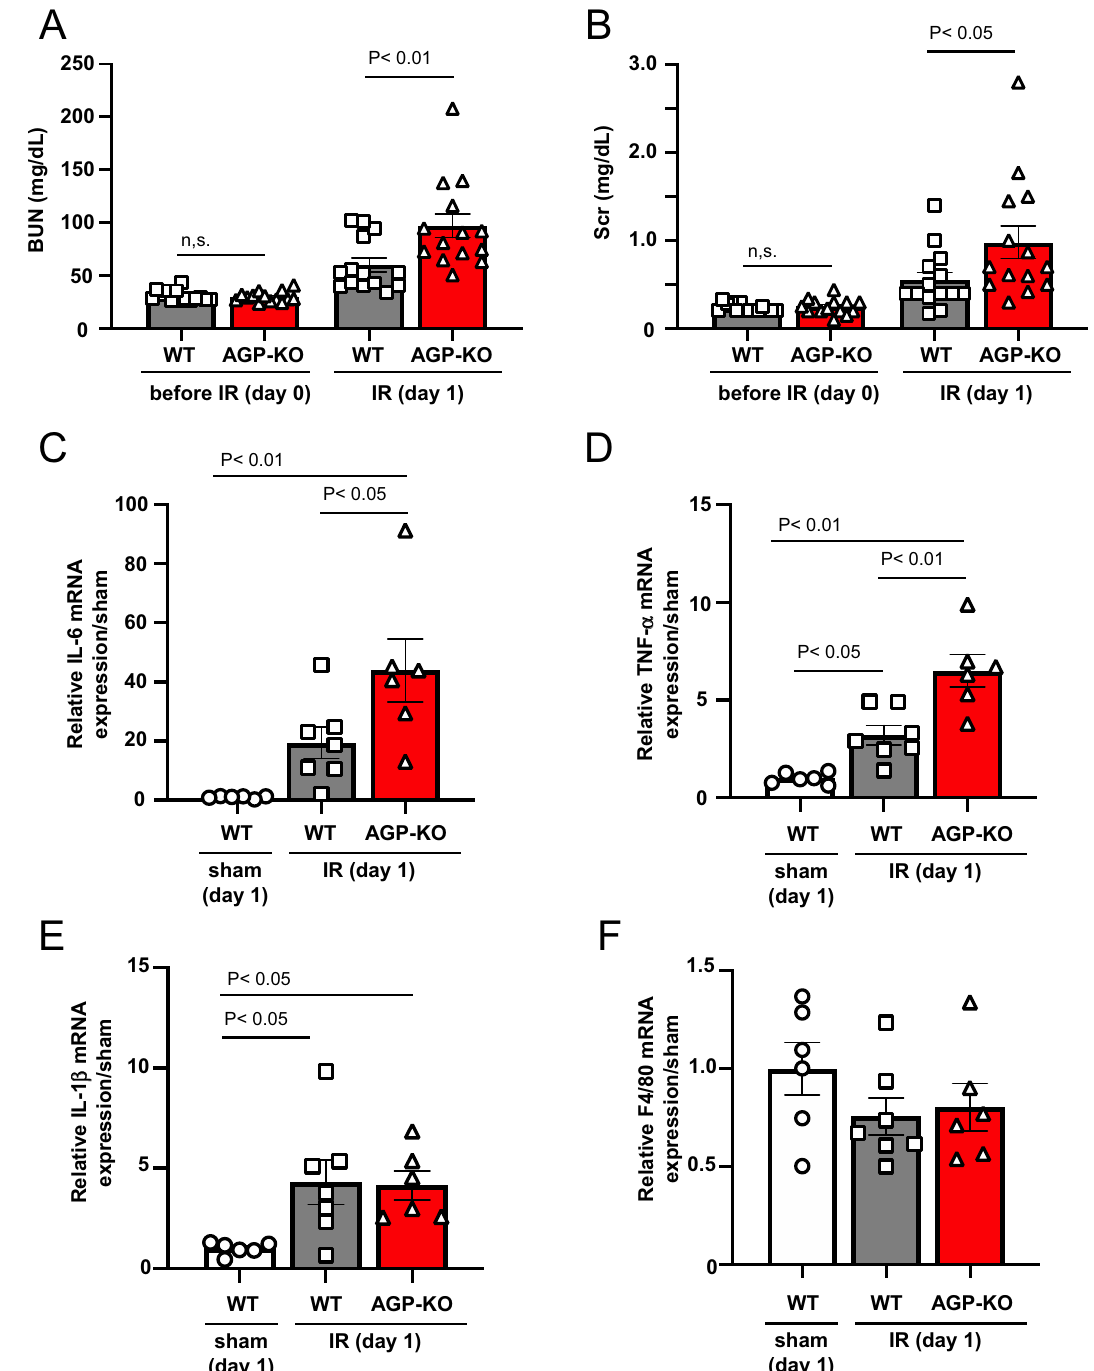
Figure 2. Systemic AGP knockout exacerbates renal function and renal inflammation at day 1 after renal ischemia–reperfusion. ( A ) Blood urea nitrogen (BUN) and ( B ) serum creatine (SCr) were measured at day 1 after renal IR (n = 14). The mRNA expression of ( C ) IL-6, ( D ) TNF-α, ( E ) IL-1β and ( F ) F4/80 in kidney at day 1 after renal IR were determined by real-time PCR (n = 6–7). Data are expressed as means ±